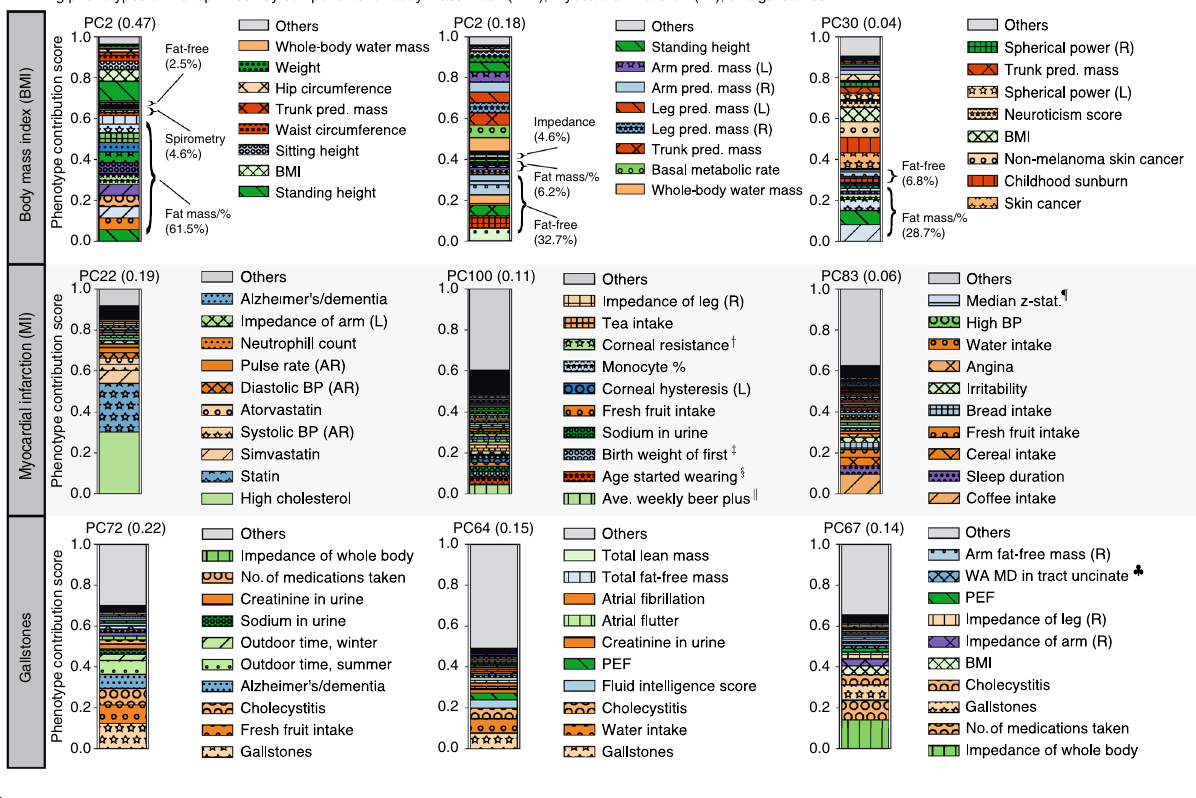
Ontology enrichment analysis with the genomic region enrichment analysis tool (GREAT) for body mass index GREAT binomial fold change Color gradient: –log 10 (GREAT binomial p